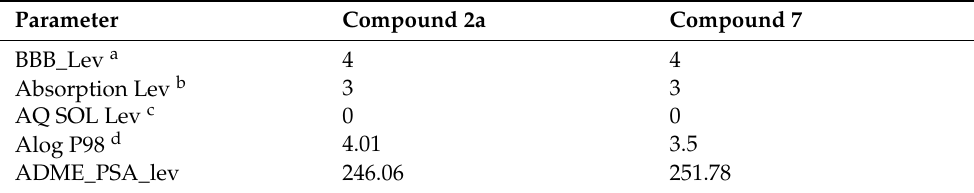
Table 6. Computer-aided ADMET parameters of 2a and 7